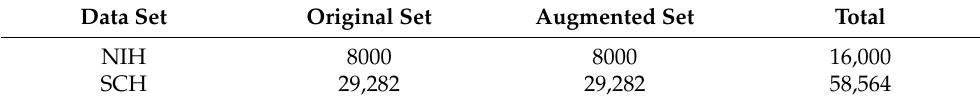
Table 3. Combination samples of the original and augmented data of the training set.